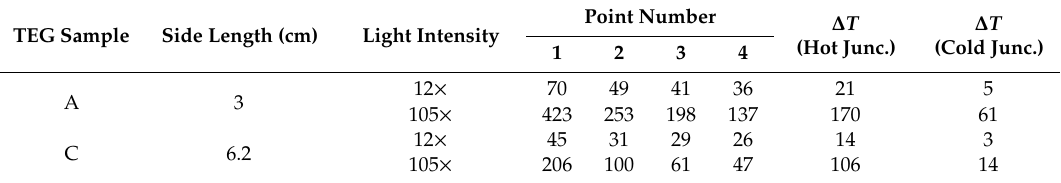
Table 2. Hot and cold junction temperatures of the 3-cm (sample A) and the 6.2-cm (sample C) TEGs operating under an illumination of 12 × and 105 × . ∆ T (hot junction) and ∆ T (cold junction) are the temperature di ff erence across each